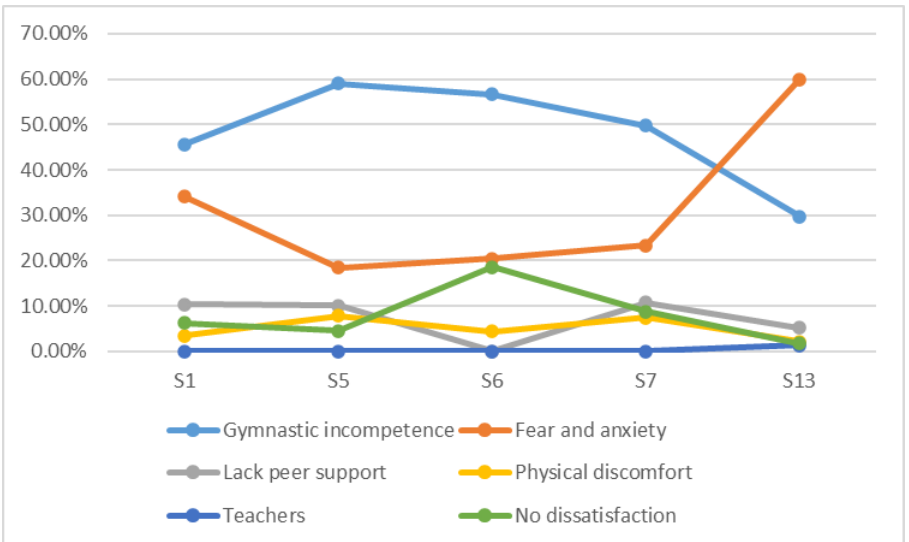
Figure 3. Dissatisfaction in gymnastics learning related to the perceptions about the gymnastic competence, fears and anxiety, lack of peer support, physical discomfort, teacher, and no dissatisfaction.